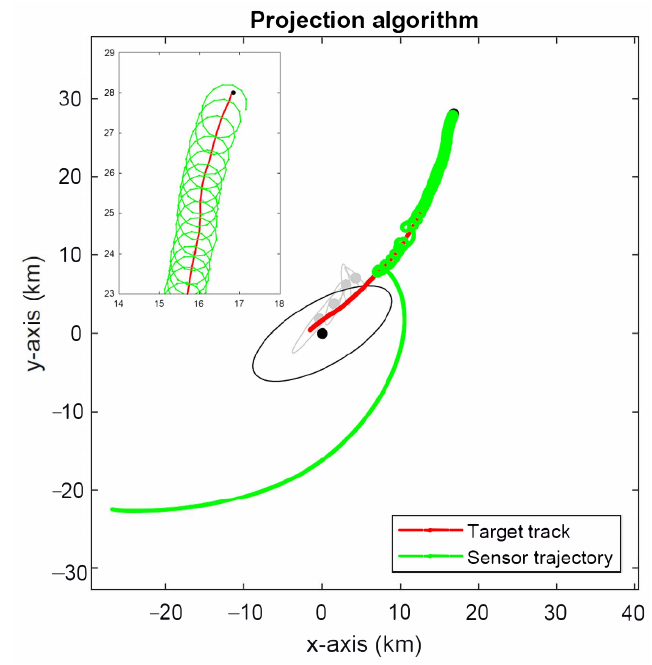
Figure 11. Optimal sensor trajectory using the projection algorithm.